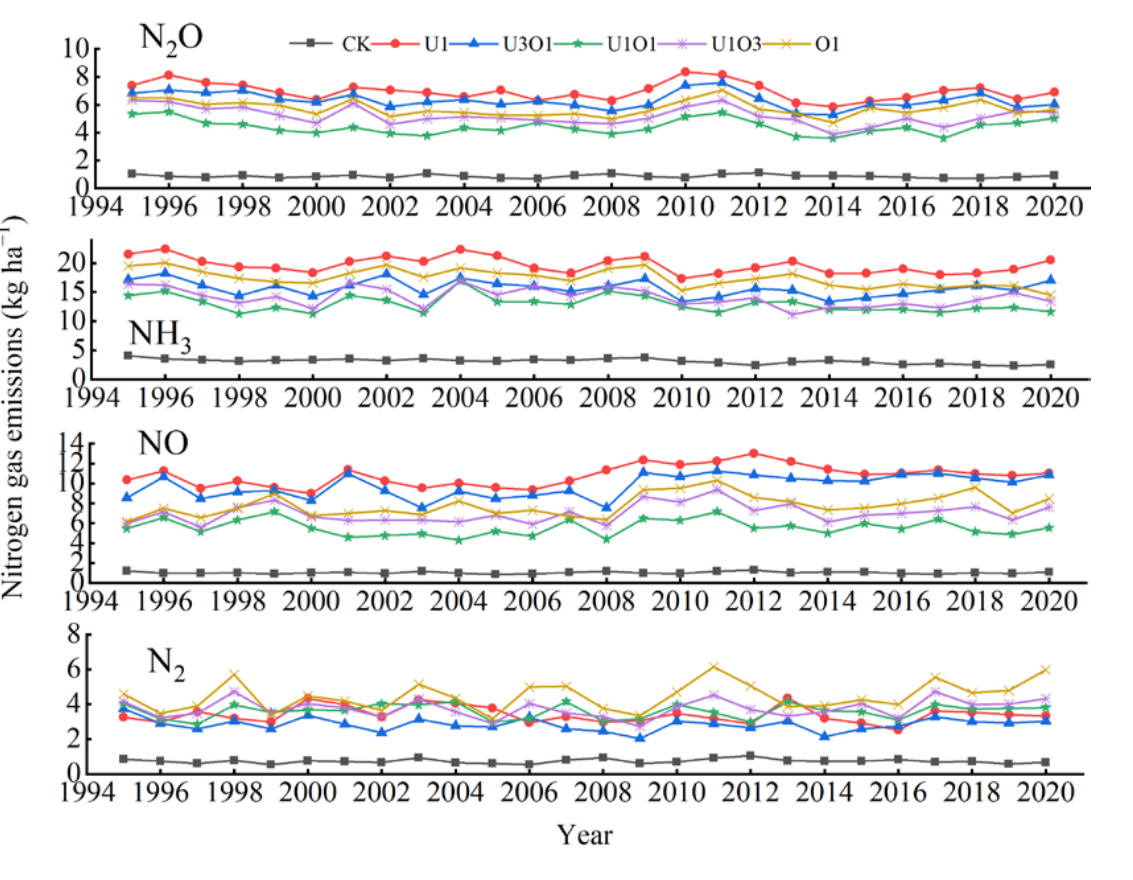
Figure 7. DNDC model of the dynamics of nitrogen-containing gas emissions under different treat- ments.